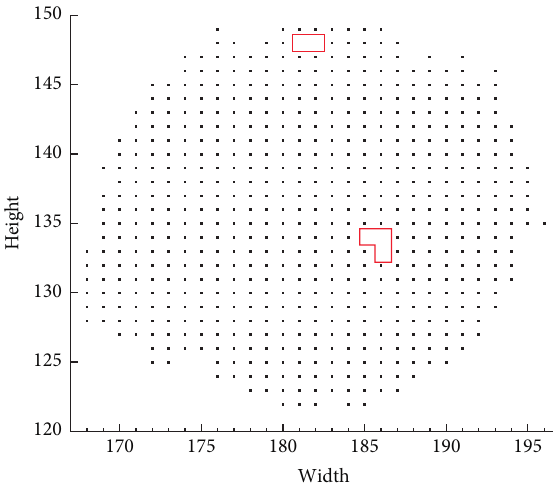
Figure 4: The pixel distribution map of the extracted head